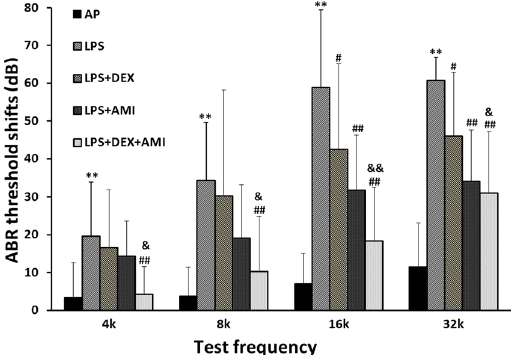
Figure 1. ABR threshold shifts (dB SPL) 48 h after surgery in each group. AP infusion alone did not cause significant ABR threshold shifts. In contrast, cochlear LPS infusion significantly induced hearing loss at all frequencies tested in guinea pigs. Smaller threshold shifts were observed in the LPS + DEX or LPS + AMI group compared to the LPS group, especially at high frequencies (16 and 32 KHz). However, the combination of DEX and AMI showed a significant protective effect against LPS-induced hearing loss at all frequencies compared to both the untreated LPS group or the LPS + DEX group at all frequencies tested. There were ten animals in each group. * and ** indicate p < 0.05 and p < 0.01 compared to the AP group, respectively; # and ## indicate p < 0.05 and p < 0.01 compared to the LPS group; & and && indicate p < 0.05 and < 0.01 compared to the LPS + DEX group,